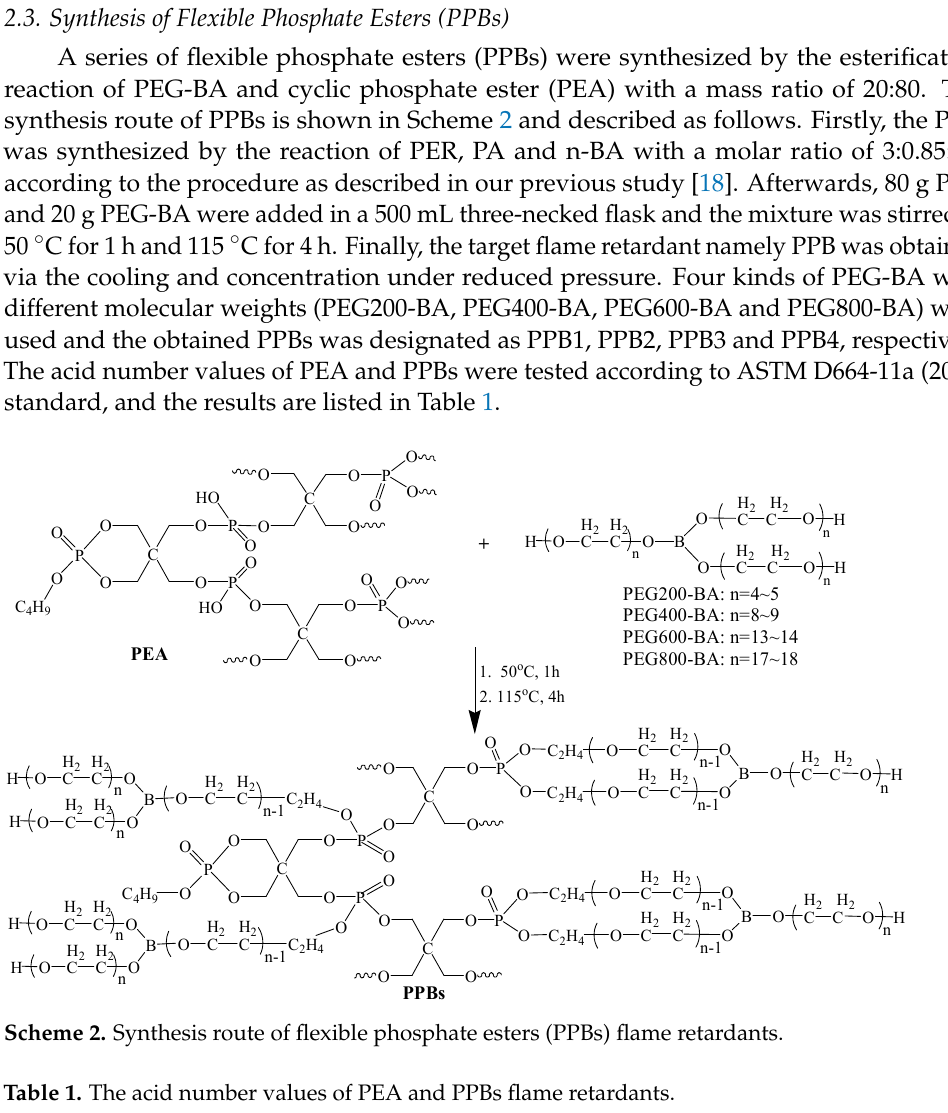
Scheme 1. Synthesis route of PEG-BA with different molecular weights.